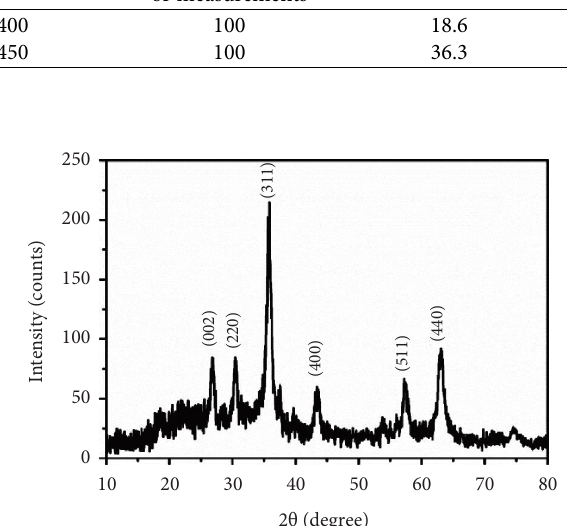
Figure 3: X-ray difraction pattern of tea treated pulp magnetite nanoparticles.